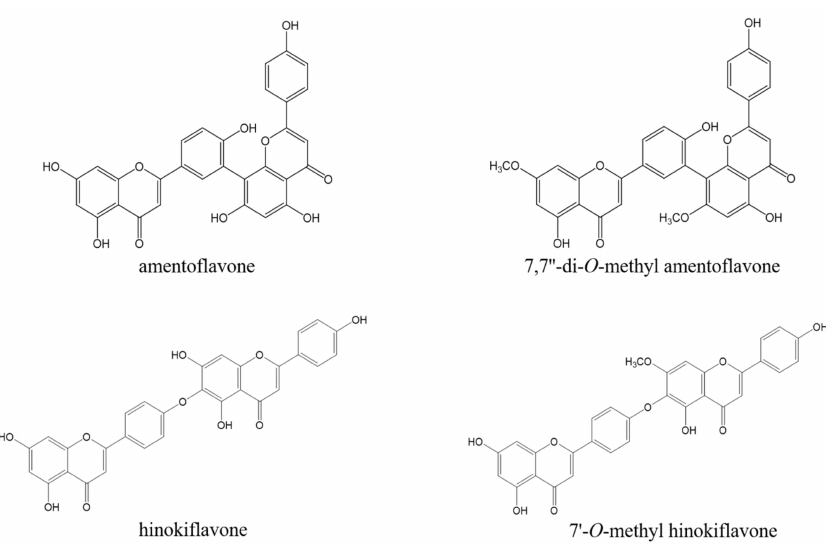
Figure 2. Chemical structure of four compounds isolated from S.